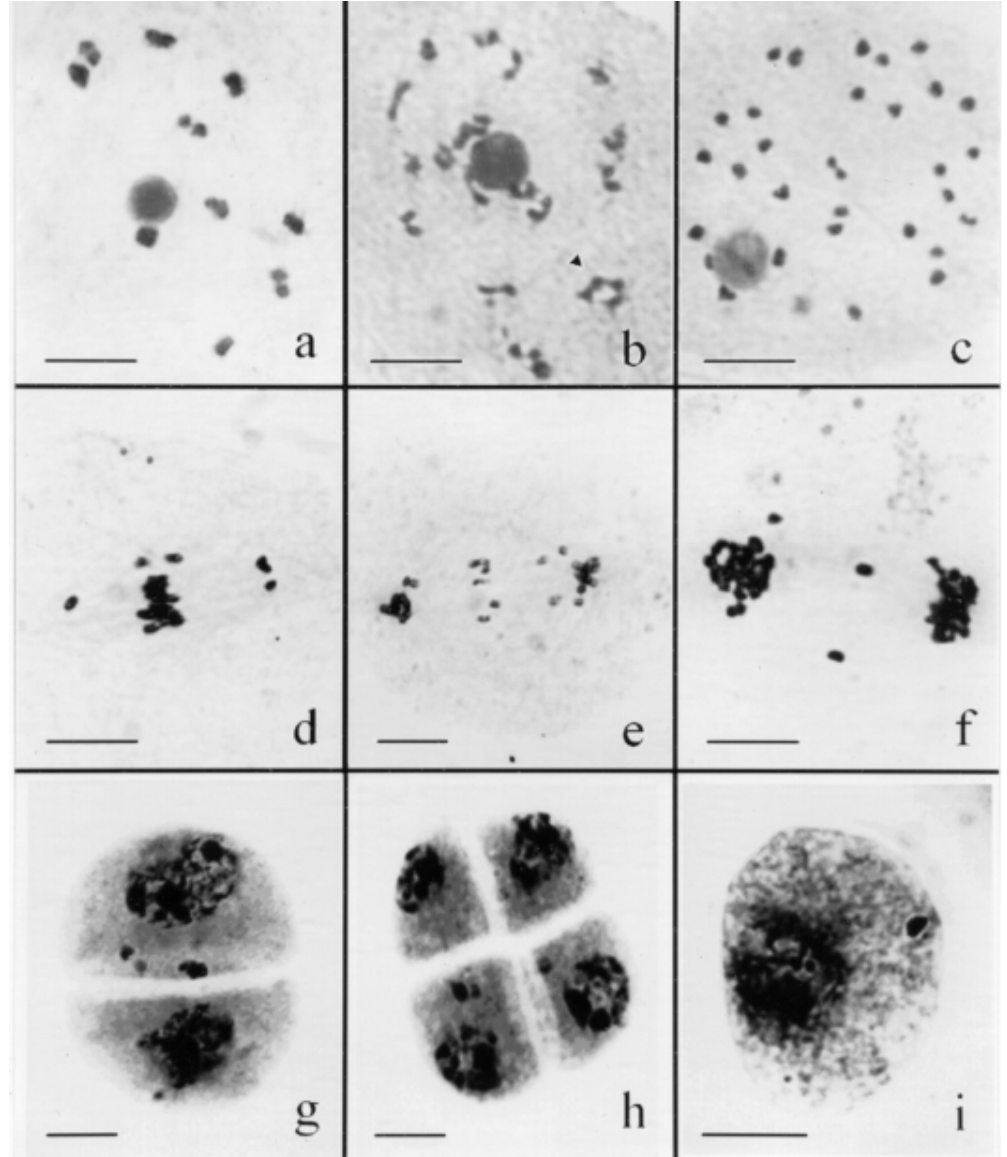
Figure 1 - Meiotic behavior in different Paspalum cytotypes. a) Diakinesis in the diploid accession of P. coryphaeum showing 10 II. b) Diakinesis in tetraploid accession showing 18 II and 1 IV (arrowhead). c) Diakinesis in the hexaploid accession of P. conspersum with 30 II. d) Metaphase I in tetraploid accession showing precocious chromosome migration to the poles. e) Anaphase I in tetraploid accession showing laggards. f) Early telophase I intetraploidaccessionwithmicronuclei.f)ProphaseIIwithmicronuclei.g)Tetradwithmicronuclei.h)Microsporewithmicronuclei.Scalebar=1 (cid:1)